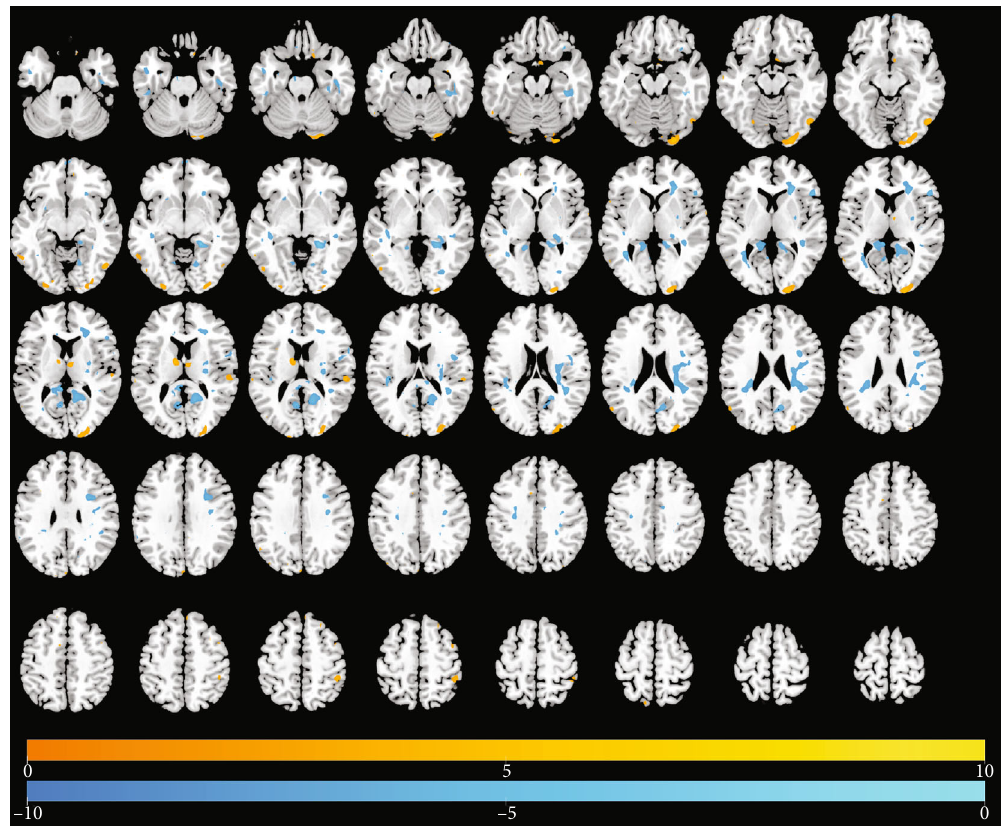
Figure 6: Di ff erences in the magnitude of DC between the same upper-limb amputee patients and control subjects at 12 months of rs-fMRI scan. Same conventions as in Figure 1. Table 7: Relative regional changes in DC at 12